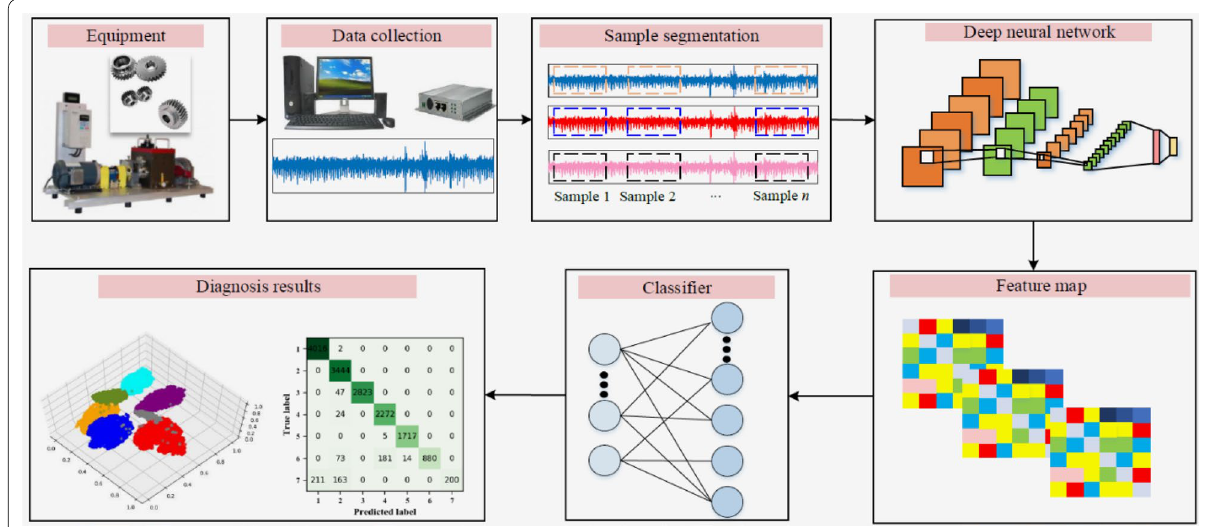
Figure 4 Flowchart of diagnosis based on deep learning